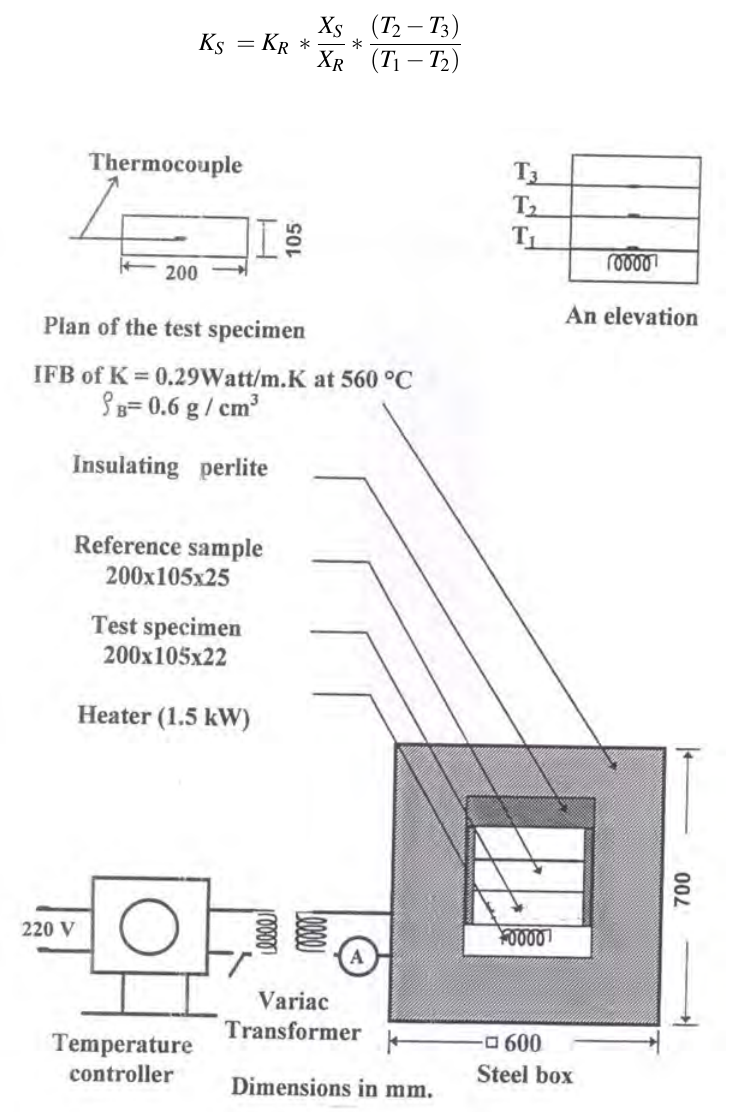
Figure 6. An apparatus to measure thermal conductivity by the comparative